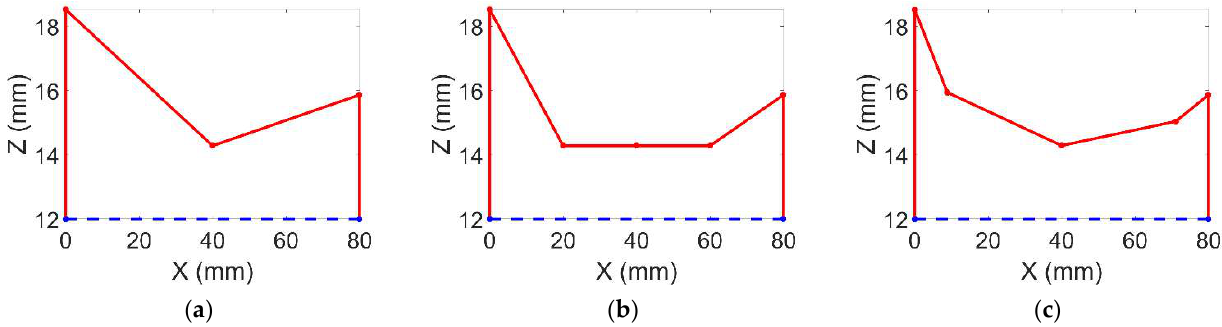
Figure 2. Example single bead surface approximations using: ( a ) triangular approach; ( b ) trapezoidal approach; ( c ) hybrid approach. Height profile is shown in red, desired Z height is shown by the dotted blue line.